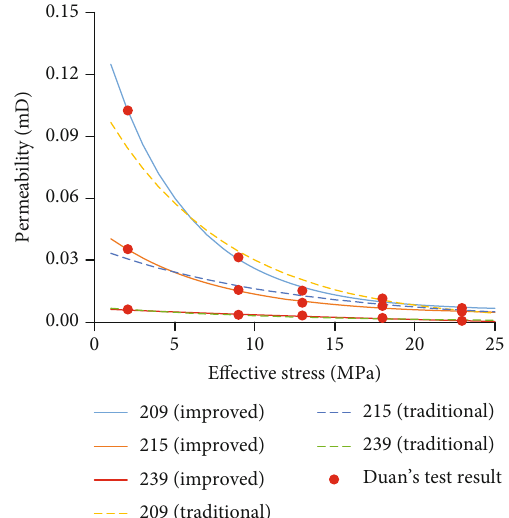
Figure 9: Model veri fi cation of the improved exponential